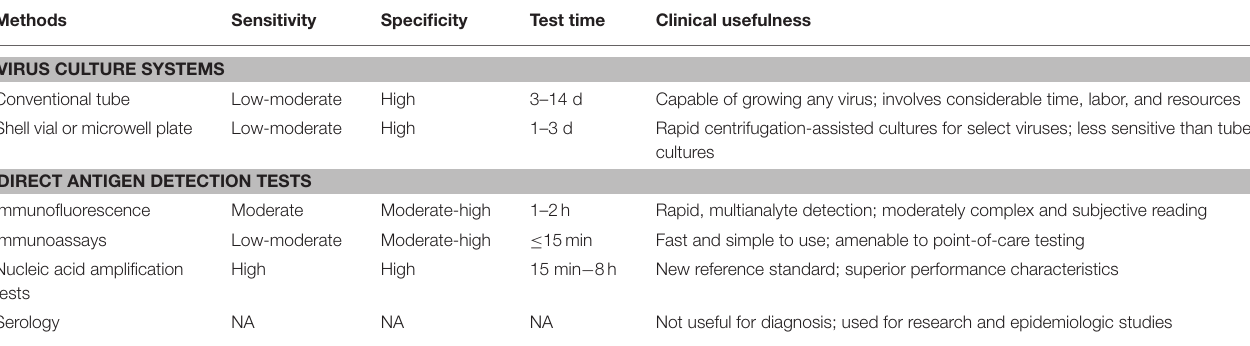
TABLE 2 | Laboratory methods for diagnosis of the major human respiratory RNA viruses a .